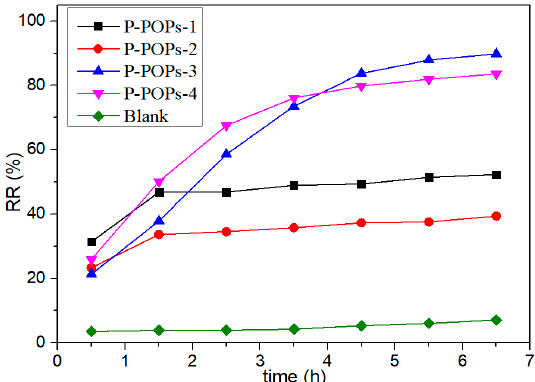
Figure 5. Effect of various catalysts on the removal rate of tetracycline. Reaction conditions: 20 mg/L tetracycline solution 40 mL, catalysts 10 mg, dark reaction 0.5 h, light reaction 6 h.